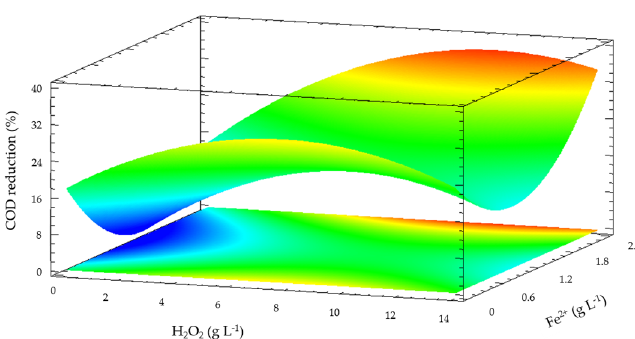
Figure 7. Response surface plot for interactive effect of H 2 O 2 dose and Fe 2+ dose on COD reduction for ferrioxalate-induced solar photo-Fenton experiments in pre-treated leachate with FeCl 3 · 6H 2 O coagulant. pH = 4.